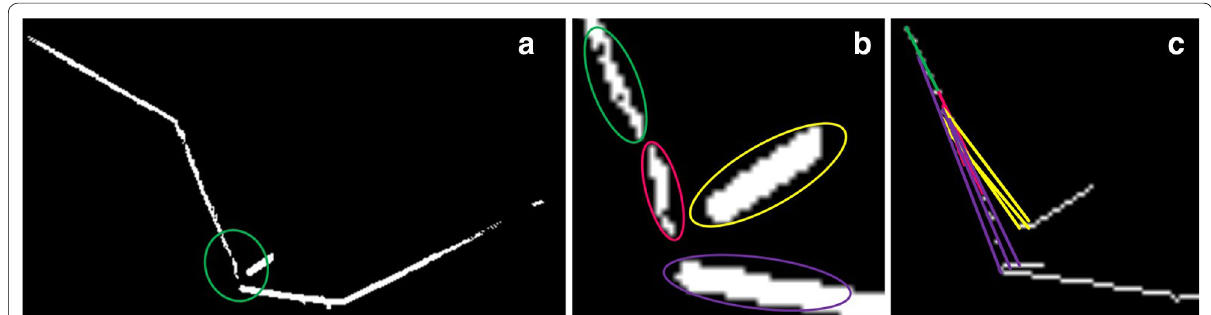
Figure 5 Illustration of the definition of the slope difference k j : a thresholding result with the interference data, b four clusters in which the green cluster is deemed the previously discerned segment of the WPS and the rest ones are candidate clusters to be discerned, c the slope differences between the last discerned cluster and the candidate ones